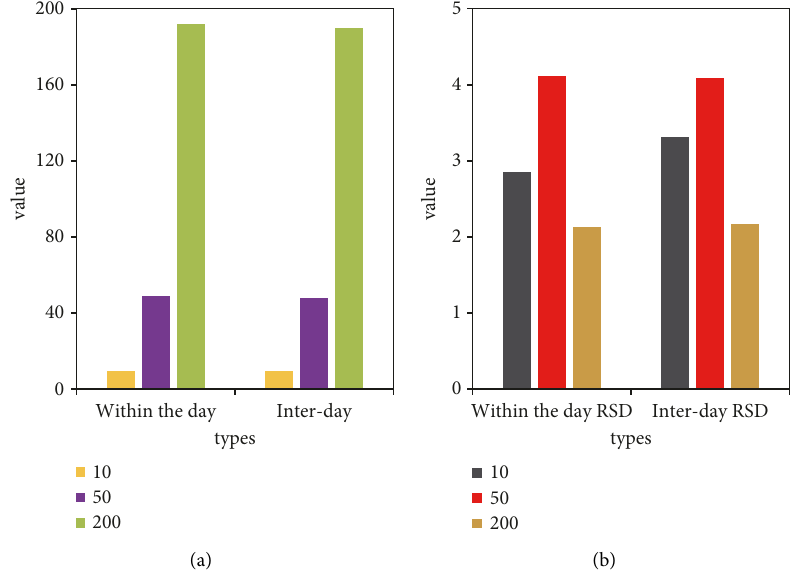
Figure 9: The extraction precision of rutin in mouse brain